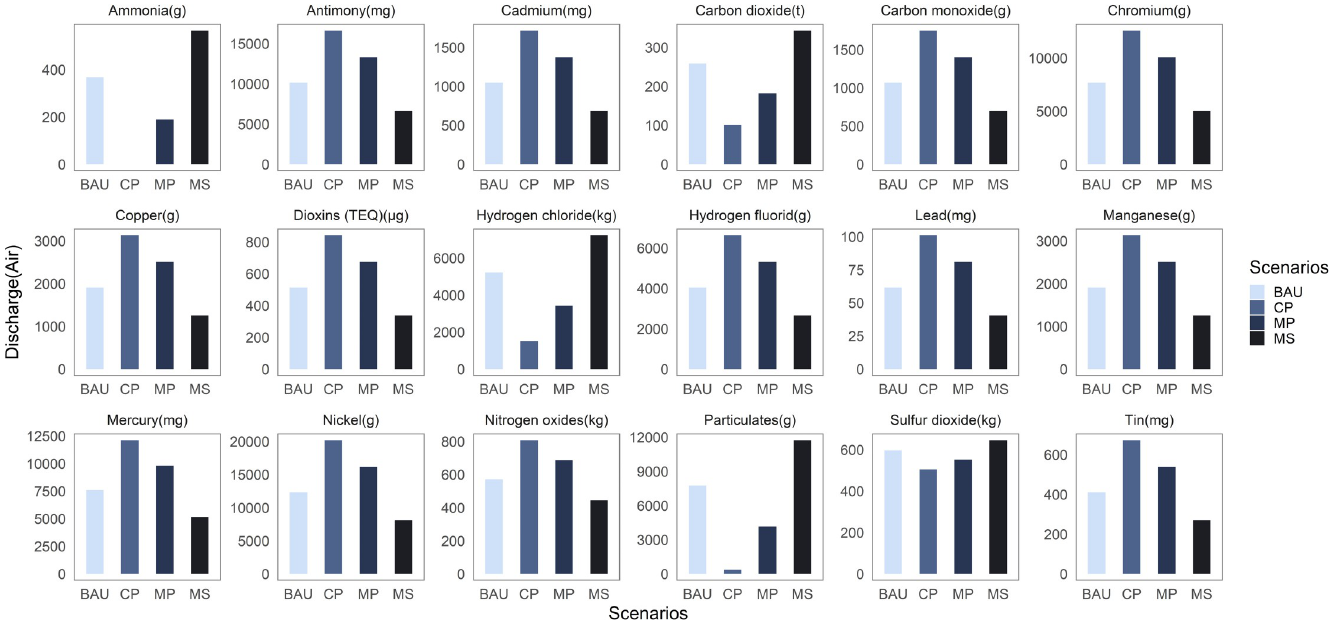
Fig 6. Bar plots depicting the exhaust gas production under the four